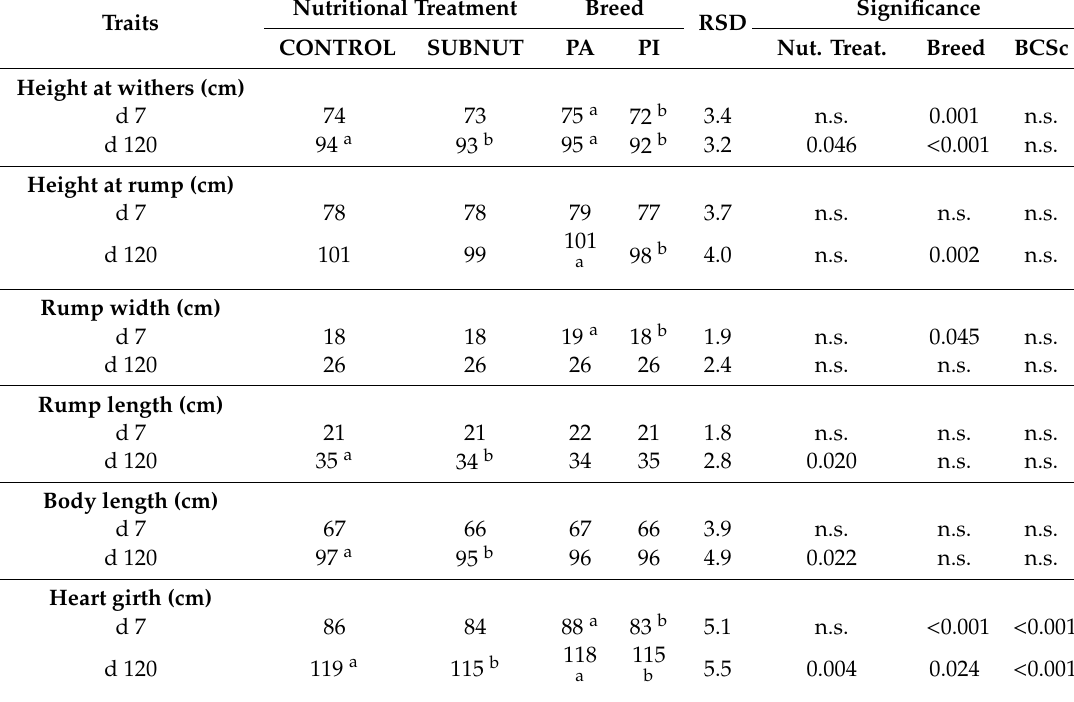
Table 4. Calf morphometric measurements throughout lactation, according to the nutritional treatment and the breed (cow BCS at calving included as a